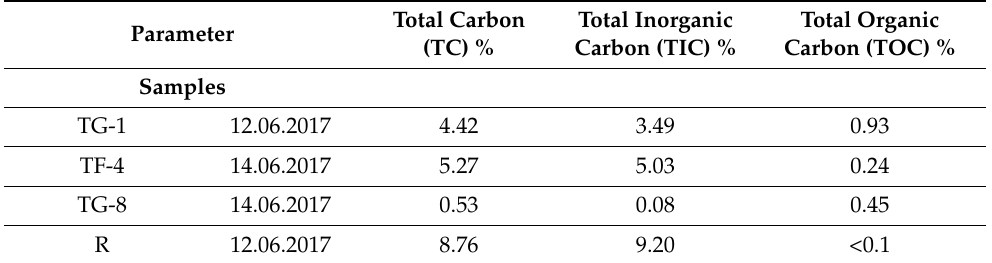
Table A5. Data on carbon content in the bottom sediments in Templefjord in front of the river (TG-1) near the glacier (TF-4), in permafrost (TG-8), and in riverine sediments (R) (June